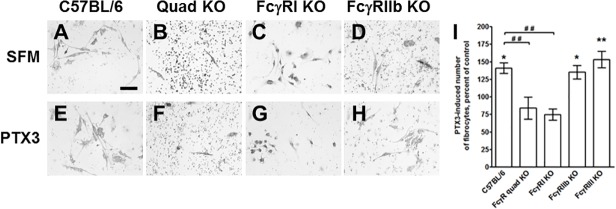
FcγRI KO and quad FcγR KO spleen cells are less sensitive to PTX3 induced fibrocyte differentiation.Spleen cells were cultured for 5 days in the A-D) absence or E-H) presence of PTX3, from A and E) wildtype C57BL/6 mice, B and F) quadruple FcγRI/IIb/III/IV, C and G) FcγRI, and D and H) FcγRIIb knockout mice. After 5 days, cells were air-dried, fixed, and stained, and the number of fibrocytes was counted. Bar is 100 μm. I) For each strain, the count in the presence of PTX3 was normalized to the count in the absence of PTX3. Values are mean ± SEM (n = 3). *p <0.05, **p <0.01 (ANOVA), compared to SFM. ## p<0.01 (ANOVA) compared to C57BL/6.